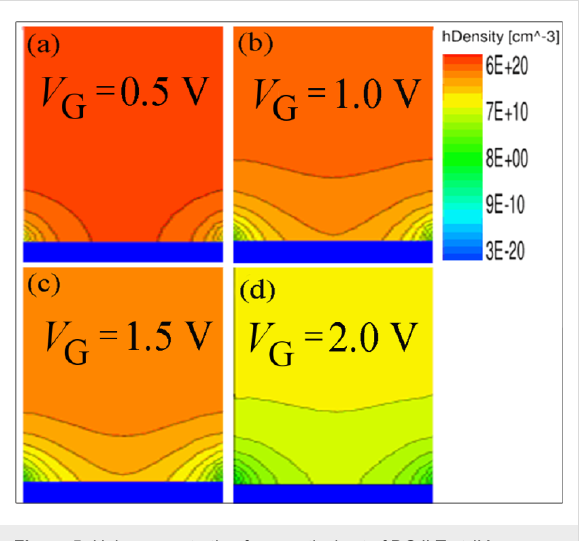
Figure 5: Hole concentration for a vertical cut of DGJLT at ( X = − 100 nm) for four different gate voltages (a) V G = +0.5, (b) V G = +1.0.,